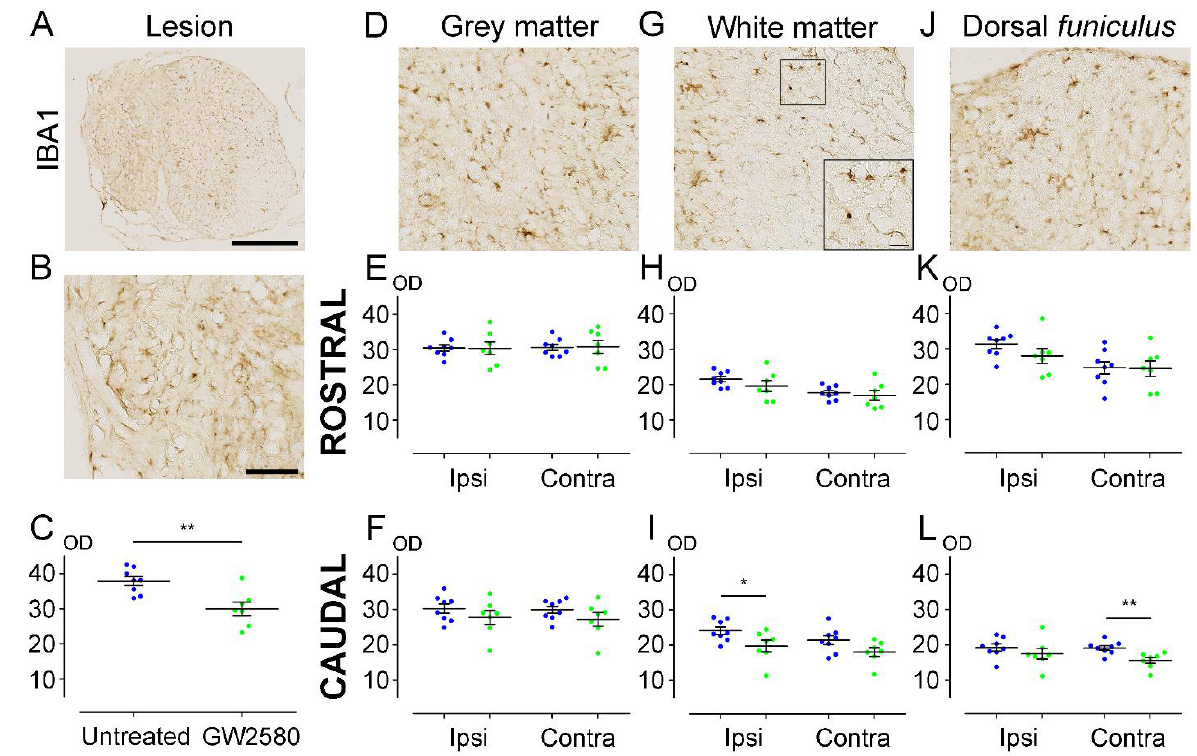
Figure 3. Long-term GW2580 treatment after SCI reduces IBA1 immunoreactivity in the injured spinal cord. Representative micrograph of IBA1 immuno-staining at the lesion epicenter ( A ). Zoomed-in micrographs in the lesion site ( B ), the grey matter ( D ), the white matter ( G ), and the dorsal funiculus ( J ) at the lesion epicenter. Six weeks after SCI, quantifications of IBA1 immunoreactivity were done in the lesion site ( C ), the grey matter ( E , F ), the white matter ( H , I ), and the dorsal funiculus ( K , L ). Optical densities were measured rostral ( E , H , K ) and caudal to the lesion site ( F , I , L ), ipsilateral, and contralateral to the lesion site. Results are expressed as mean ± SEM in untreated (blue) and GW2580-treated groups (green). Each dot corresponds to a minimum of 9 sections (630 µ m interval between each section) analyzed per animal. Statistics: Student’s unpaired t -test. Number of mice: 8 for the untreated group and 7 for the GW2580-treated group. * p < 0.05; ** p < 0.01. scale bars: 500 µ m ( A ); 100 µ m ( B , D , G , J ); 20 µ m ( G ) ( right bottom